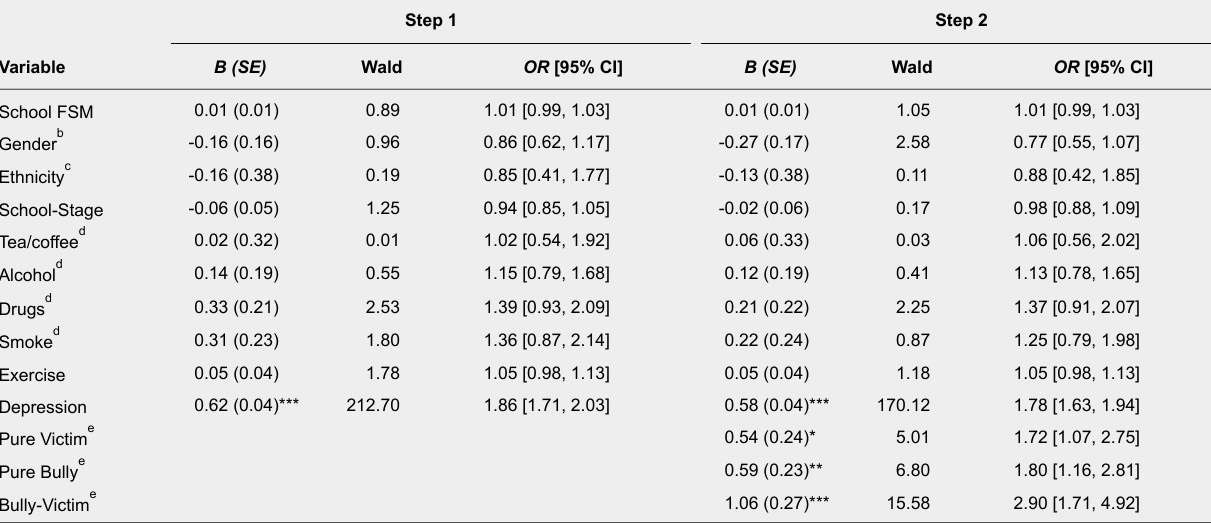
Resultsa Predicting Likelihood of Sleep Difficulty Group Membership